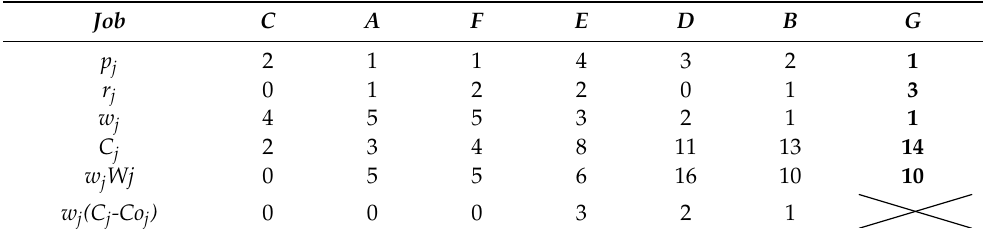
ble 5. ble 5. Table 5. Optimal solution after disruption caused by job G arrival. Table 5. Optimal solution after disruption caused by job G arrival. Table 5. Optimal solution after disruption caused by job G arrival.